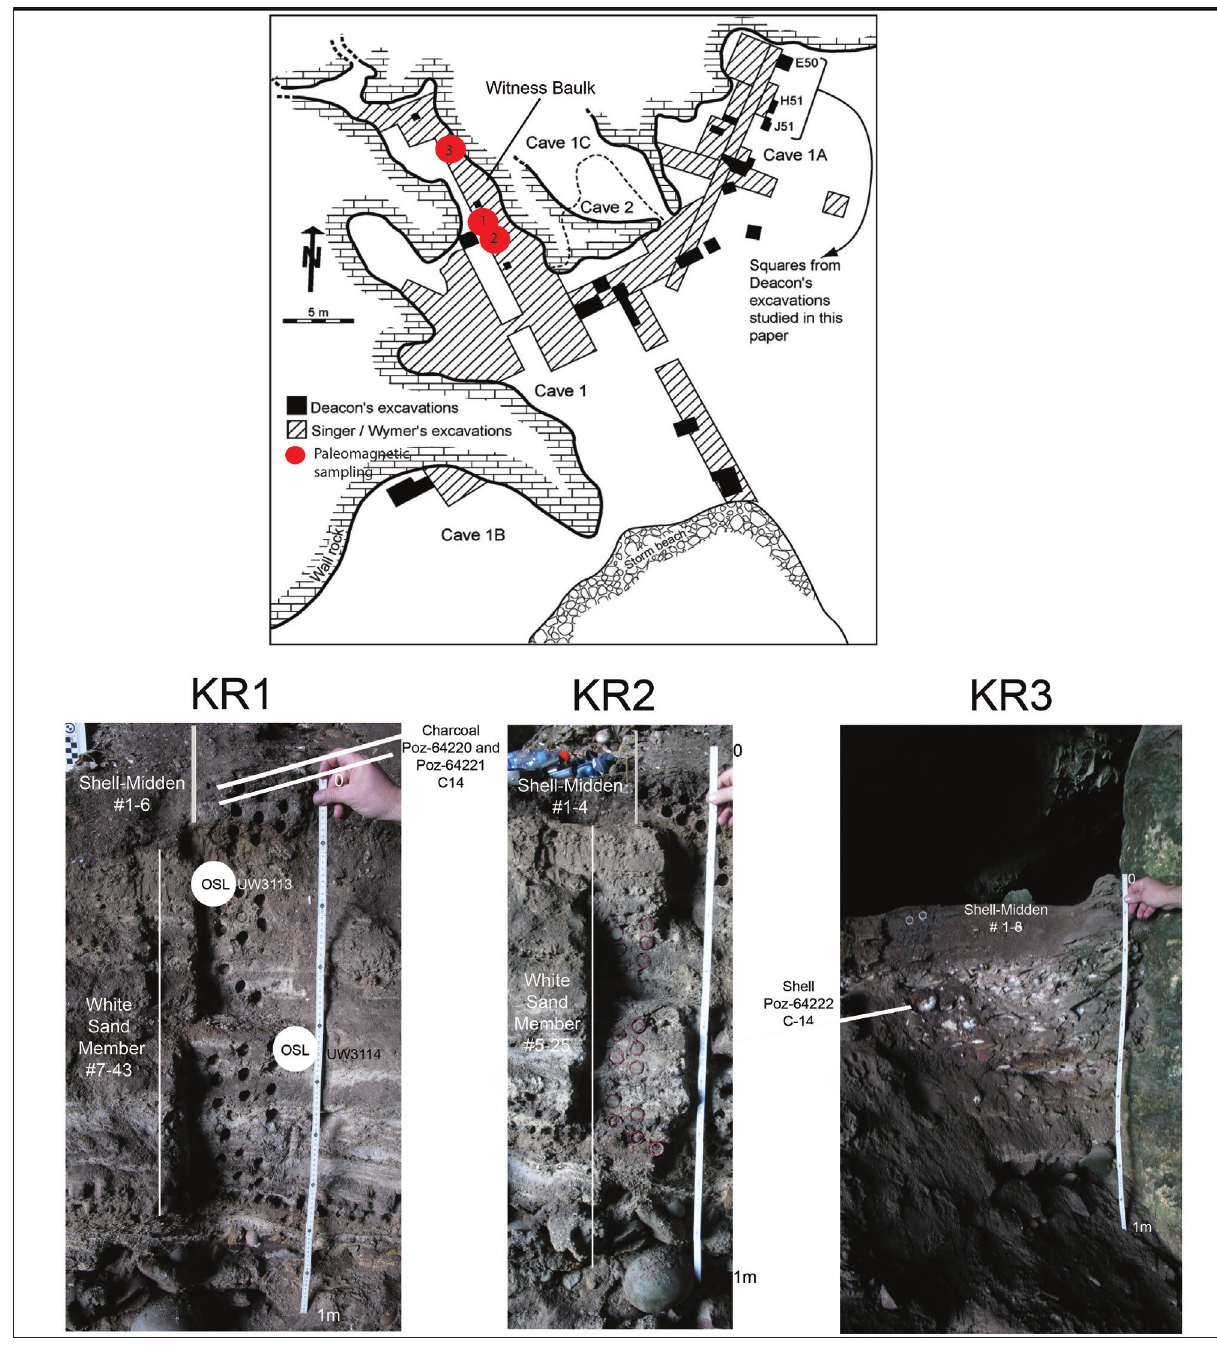
Source (upper panel): Modified after Deacon and Geleijnse 33 Figure 2: (upper) Map of Cave 1 showing the location of the three palaeomagnetic samplings in the Witness Baulk. (lower) Close-ups of the three palaeomagnetic and dating samplings (OSL and